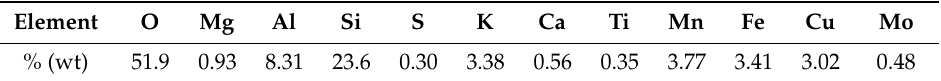
Figure 2. EDS analysis ( a ) and scanning electron microscopy (SEM) image (X 300) of sample LB ( b ). Table 2. Semi-quantitative analysis of sample LB.